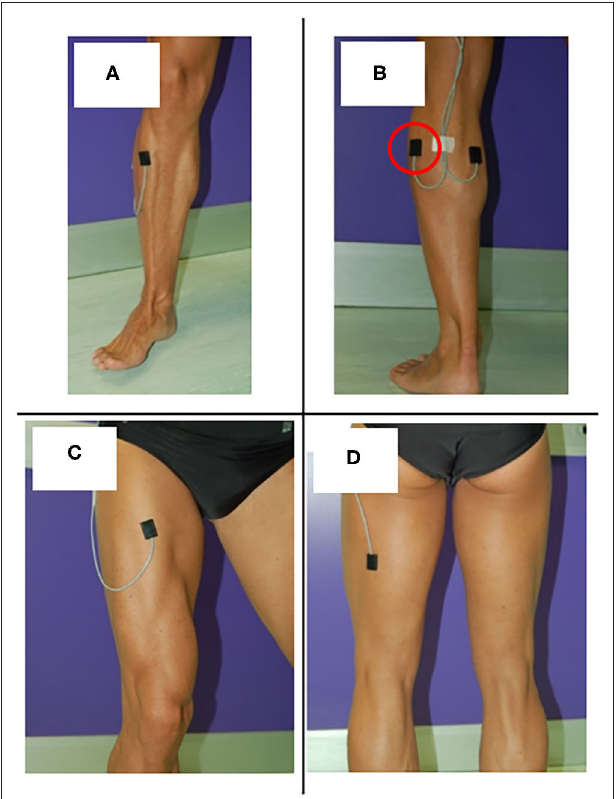
FIGURE 1 | Surface EMG probes positioned over (A) Tibials Anterior (TA), (B) Lateral Gastrocnemius (LGS), (C) Rectus Femoris (RF), and (D) Lateral hamstrings